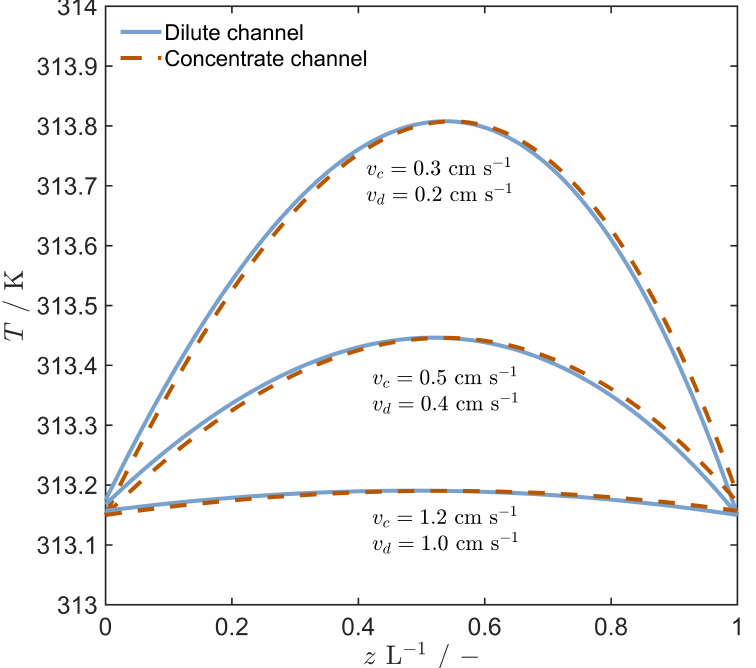
Figure 7. Temperature profiles of concentrate (dashed line, orange) and dilute (solid line, blue) channels with varied flow velocities. Inlet temperature and salt molalities are specified by the evaporation case . Dilute flow enters the cell at z L − 1 = 1, concentrate enters at z L − 1 =